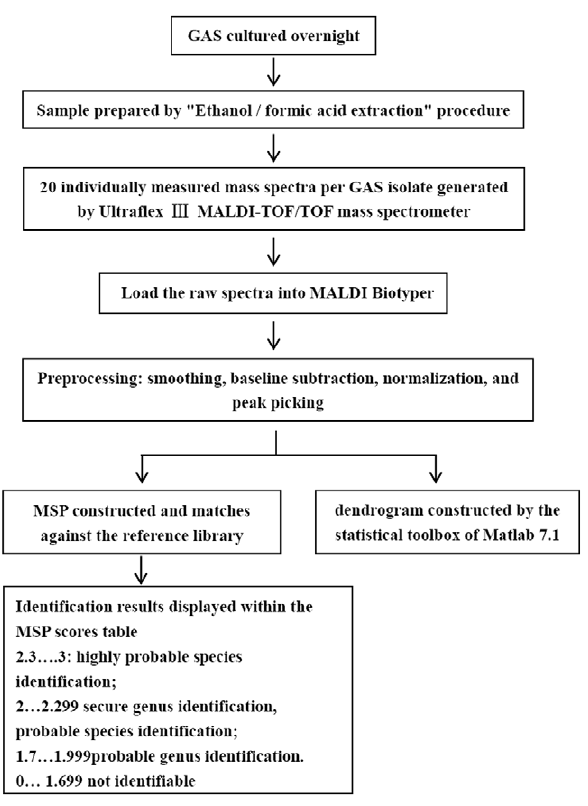
Figure 5. Schematic overview of the procedure involved in identification and cluster